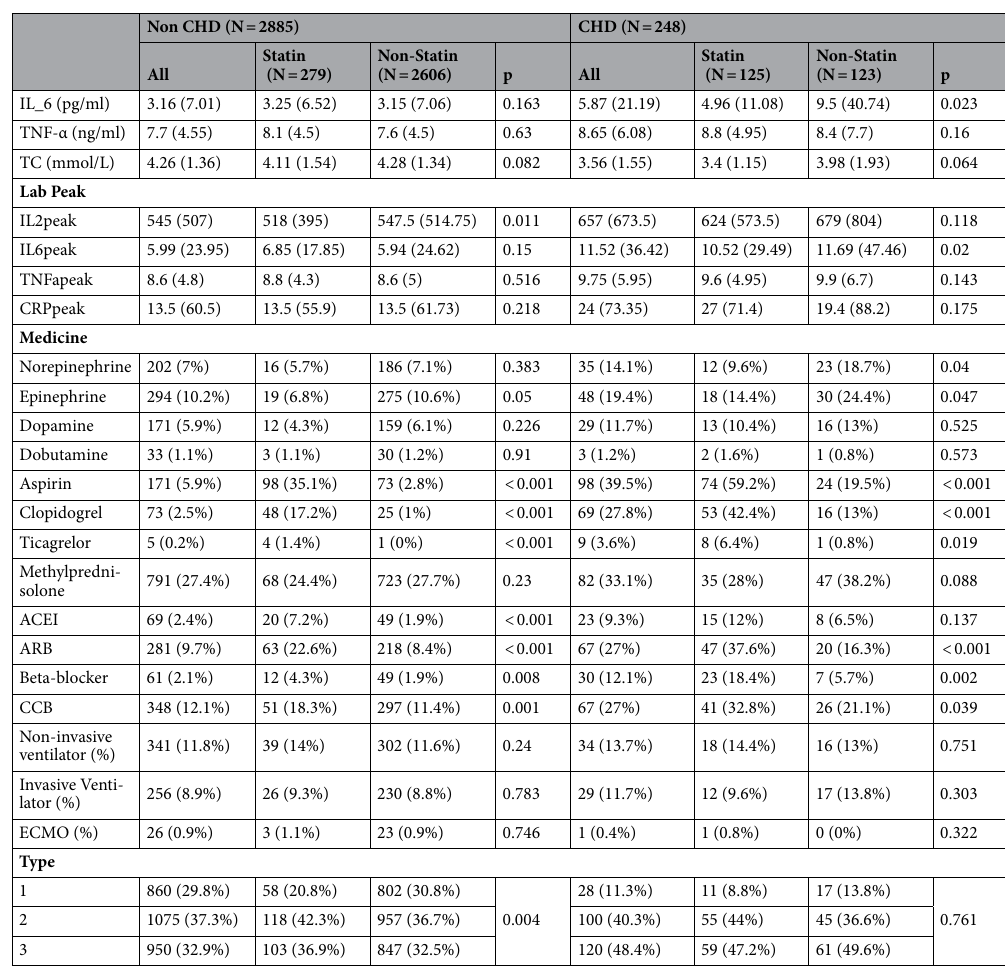
Table 3. Baseline characteristics of the study population by statin use in CHD or non-CHD population. CHD, coronary heart disease; BNP, serum B-type natriuretic peptide; TNI, Troponin I; ALT, Alanine Aminotransferase; AST, Aspartate transaminase; Cr, Creatinine; ALB, Albumin; LDH, Lactate dehydrogenase; WBC, White blood cell; Lymph, Lymphocyte; Plt, Platelet; CRP, C Reactive Protein; IL-2, Interleukin 2; IL-6, Interleukin 6; TNF-α, P.C.T., Procalcitonin; Tumor necrosis factor-α; APTT, activated partial thromboplastin time; INR, international normalized ratio; TC, Total Cholesterol; ACEI, Angiotensin-converting-enzyme inhibitors; ARB, angiotensin receptor blockers; CCB, Calcium Channel Blocker; ECMO, Extracorporeal membrane oxygenation. Continuous variables are presented as median (IQR), categorical variables are presented as n